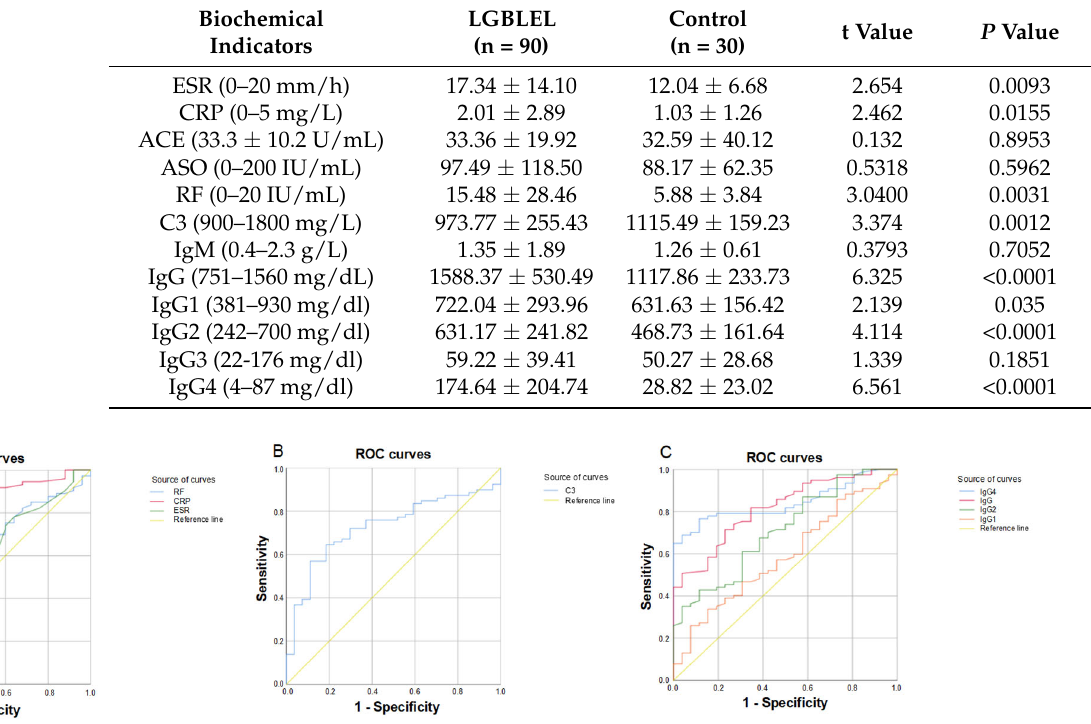
Figure 2. ROC curves of different effective indicators. ( A ) ROC curves of RF, CRP, and ESR; ( B ) ROC curve of C3; ( C ) ROC curves of IgG4, IgG, IgG2, and IgG1. We performed a binary logistic regression analysis on these eight detection indicators, which differed in level between the two groups. The results demonstrate that C3, IgG, and IgG4 were independent predictors of LGBLEL (Table 2, p < 0.05), while ESR, CRP, RF, IgG1, and IgG2 were not independent predictors of LGBLEL (Supplementary Table S1, p > 0.05). In addition, the prediction model we constructed (IgG4+IgG+C3) had the best prediction accuracy for the diagnosis of LGBLEL. Its ROC AUC reached 0.926, which had the greatest diagnostic value, and was significantly better than that of any single factor (Figure 3). The ROC AUC of IgG4+IgG was 0.892, which signaled high diagnostic efficacy, and exceeded